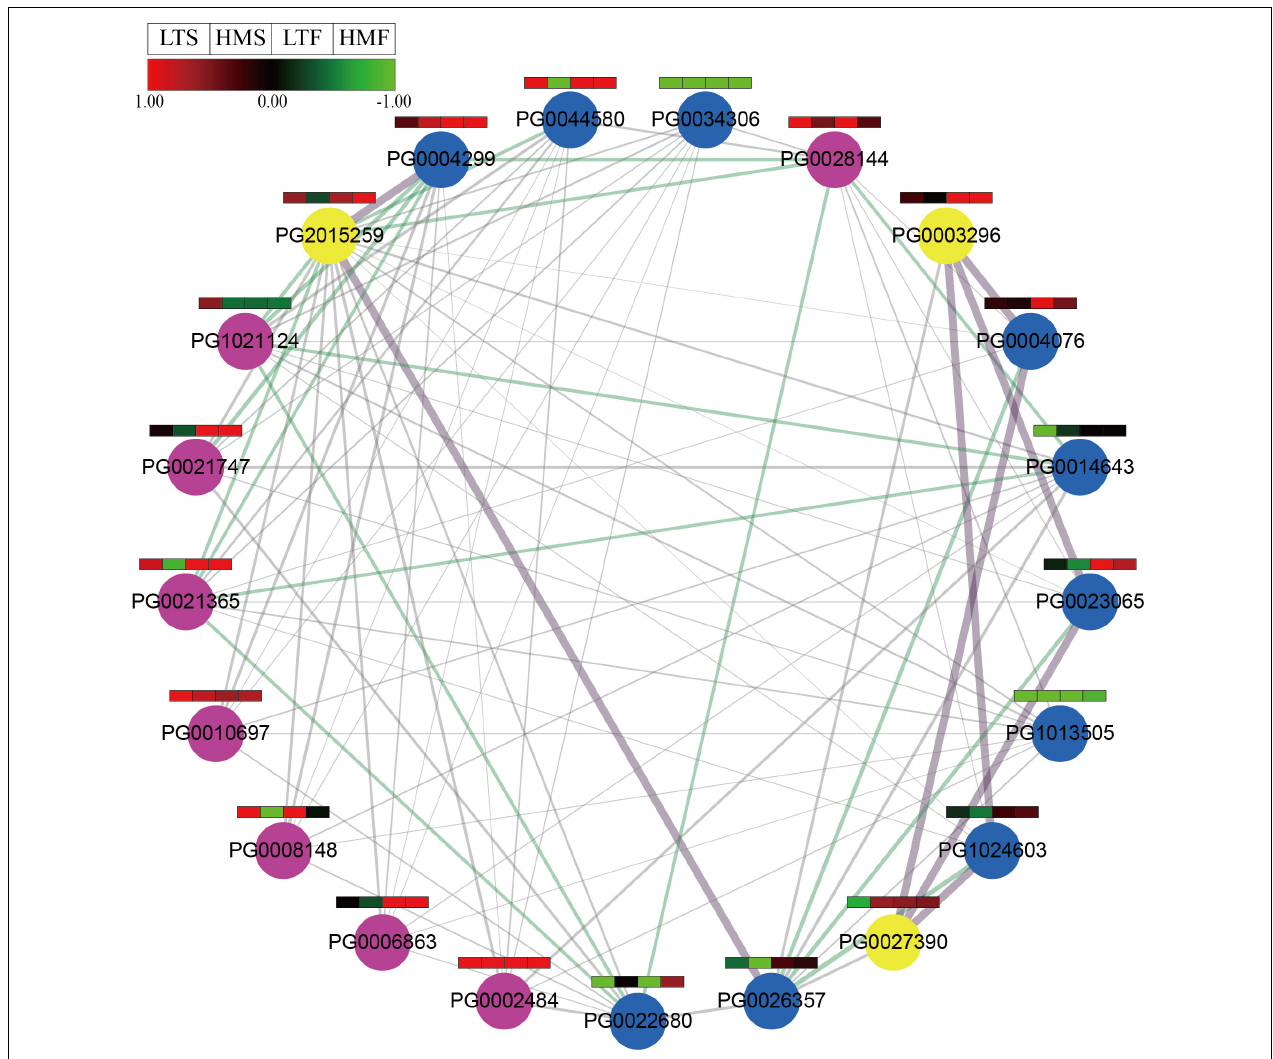
FIGURE 10 | Protein interaction network predicted for StNF-Y (combined score of 400, medium confidence). The purple lines represent the highest confidence (combined score > 900), the green lines indicate high confidence (combined score > 700), and the gray lines indicate medium confidence (combined score > 400). NF-YA subunits are highlighted in purple, NF-YB subunits are highlighted in blue, and NF-YC subunits are highlighted in yellow, respectively. The color scale was plotted using the log 2 FC of each